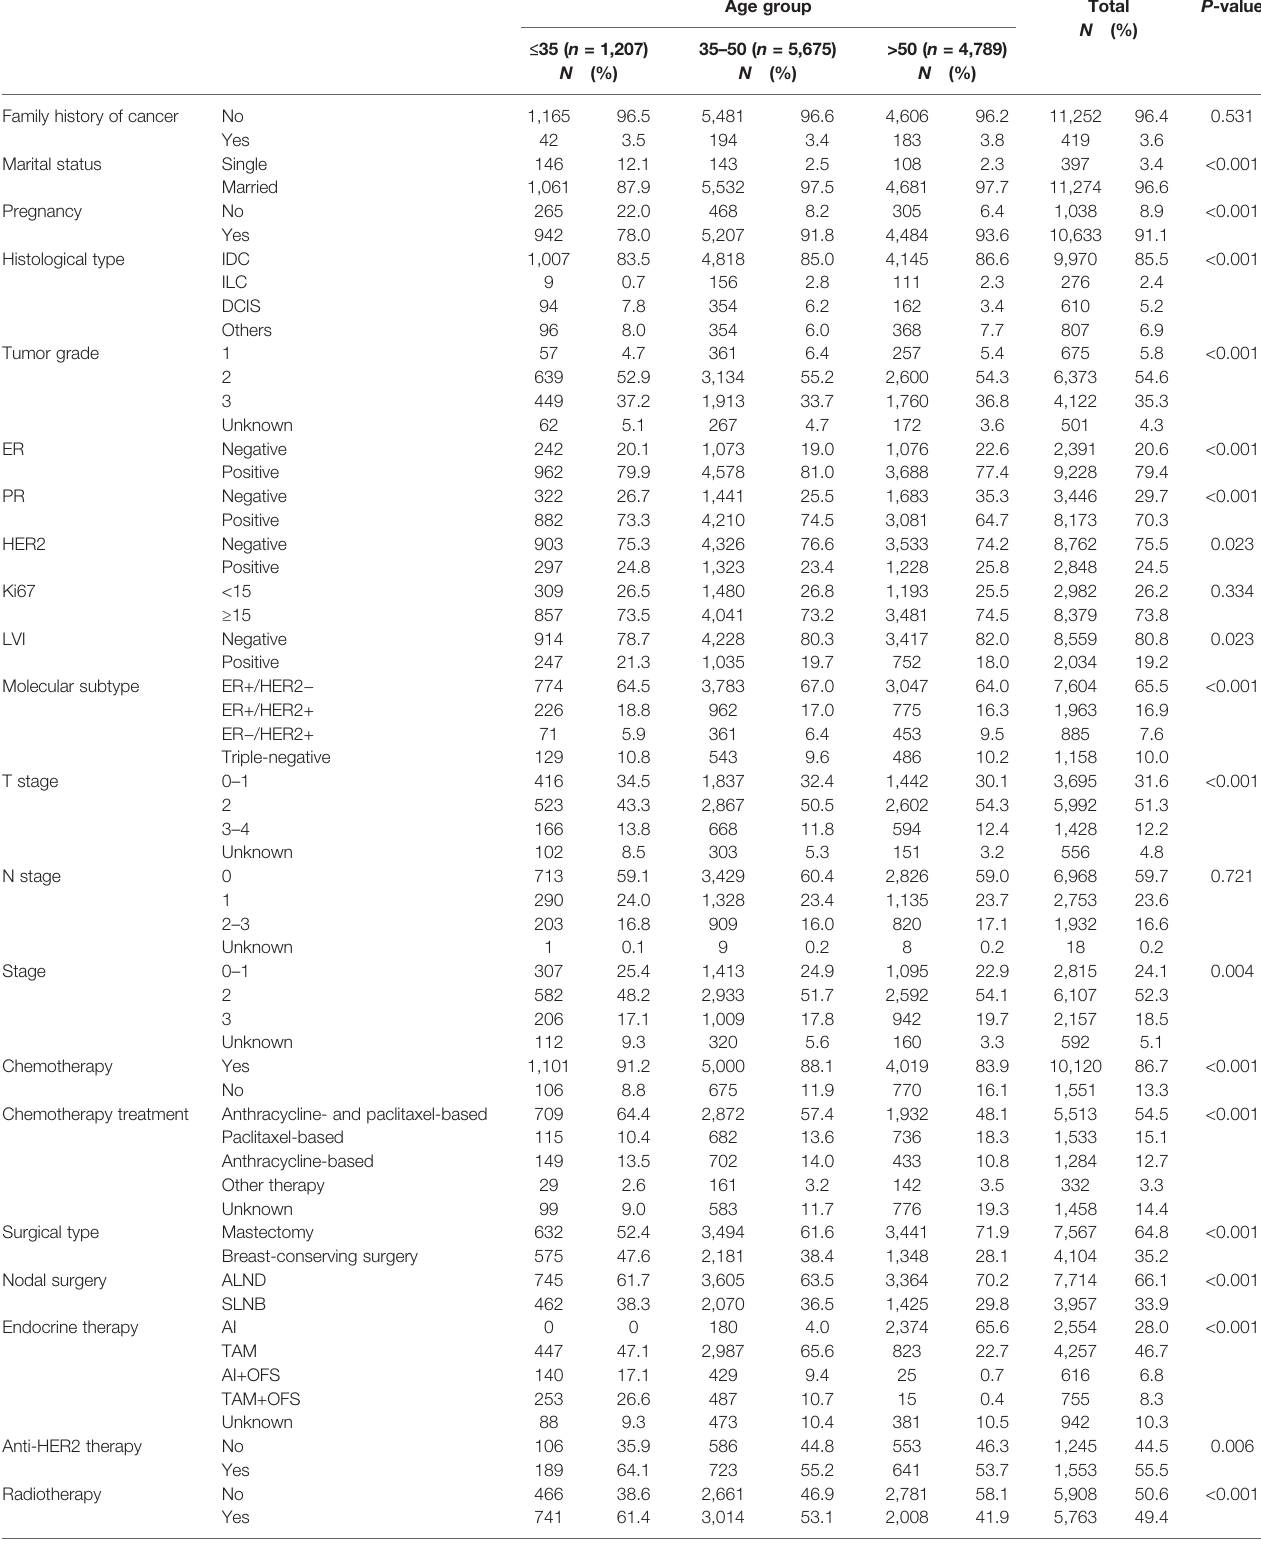
Age group Total